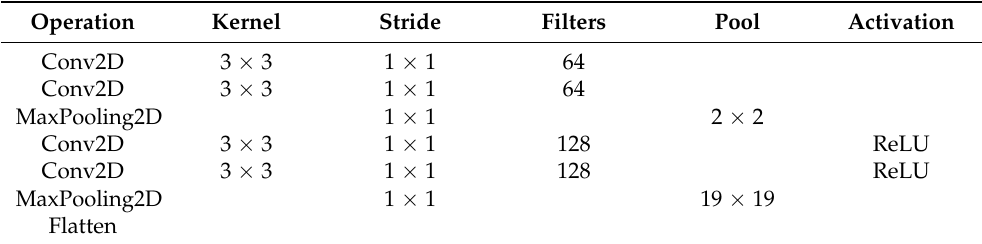
Table 4. Architecture for convolutional-related